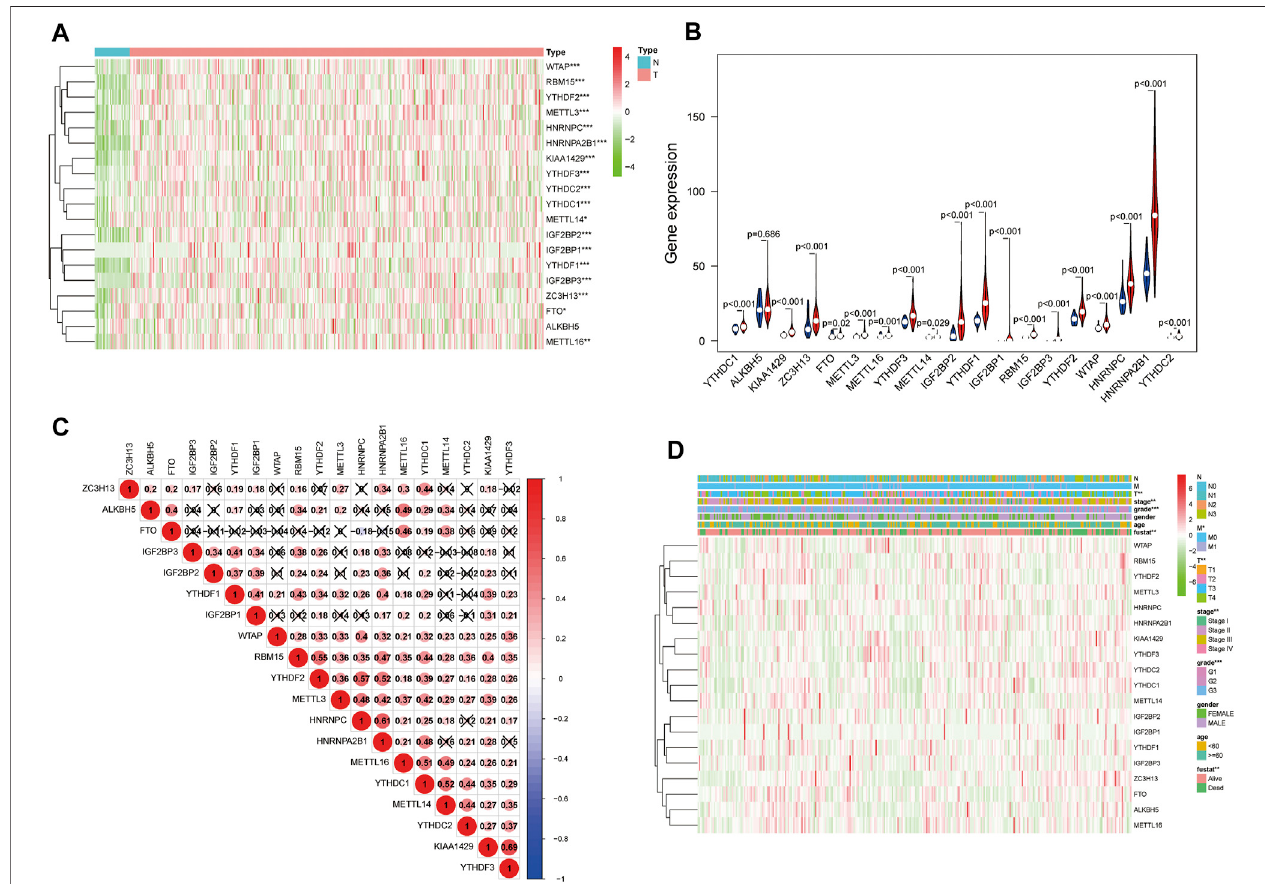
FIGURE 1 | m6A modi fi cation genes in GC in the TCGA database. (A) Heatmap shows the expression of the 19 m6A modi fi cation genes in 375 GC and 32 adjacent normal tissues. The higher or lower the expression, the darker the color; red represents upregulated, and green, downregulated m6A modi fi cation genes. (B) Vioplot visualizing the differentially expressed m6A modi fi cation genes in different tissue samples in GC; blue represents adjacent normal tissues, and red, GC tissues). (C) Spearman correlation analysis of the 19 m6A modi fi cation genes in GC. (D) Expression of m6A modi fi cation genes in GC with different clinicopathological features. * p < 0.05, ** p < 0.01, and *** p < 0.001. GC, gastric cancer.